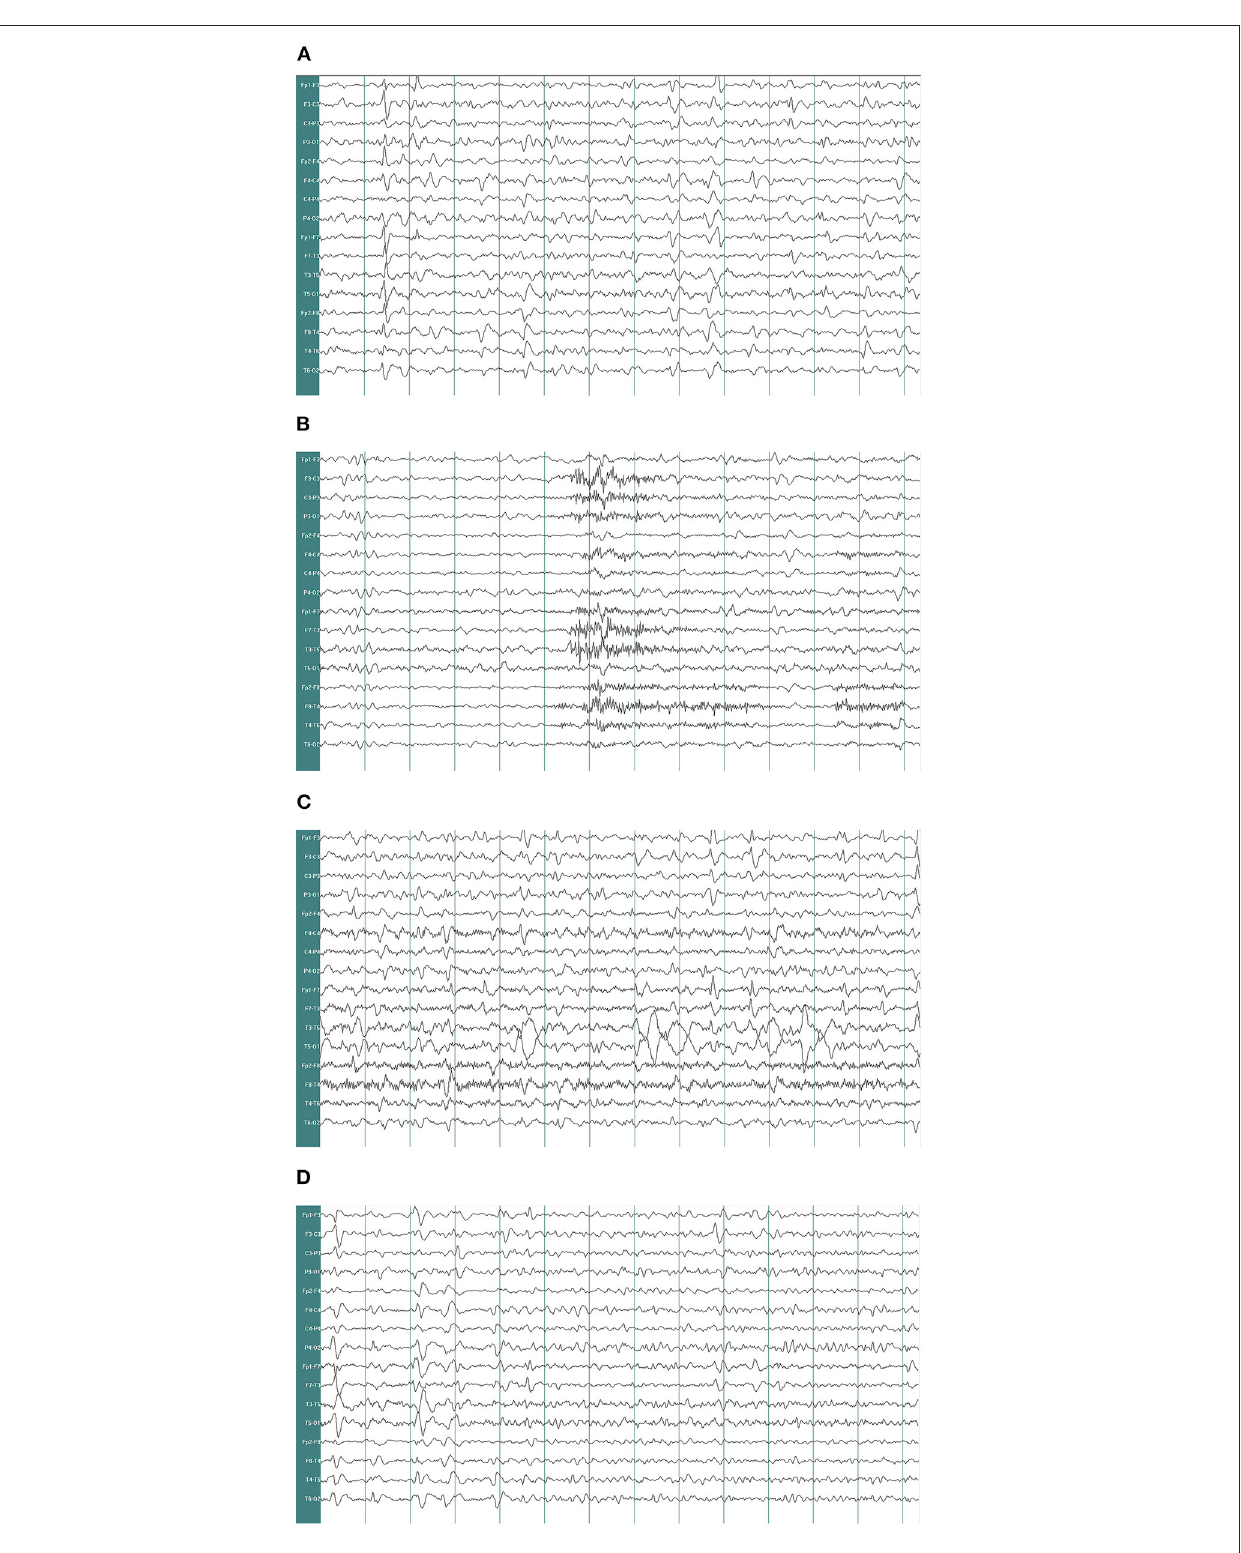
Frontiers in Neurology |